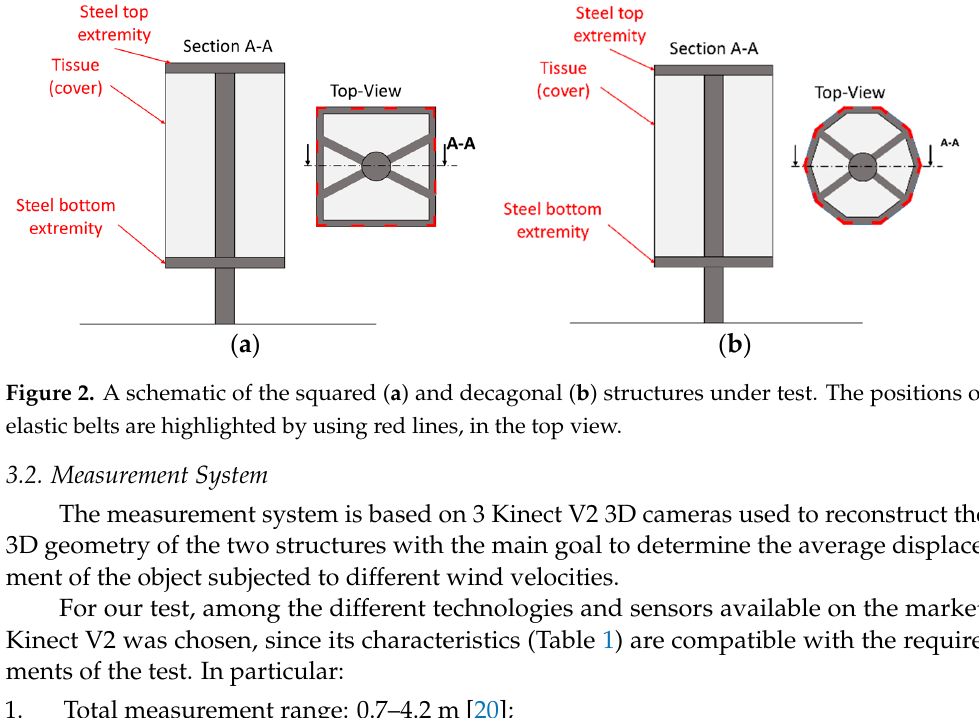
Figure 2. A schematic of the squared ( a ) and decagonal ( b ) structures under test. The positions of elastic belts are highlighted by using red lines, in the top view.